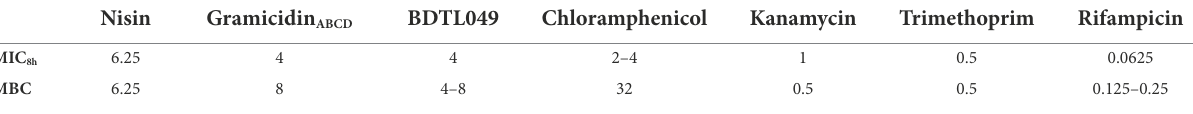
TABLE 1 Minimal inhibitory concentration (MIC) and minimal bactericidal concentrations (MBC) of depicted antibiotics against B. subtilis W168.